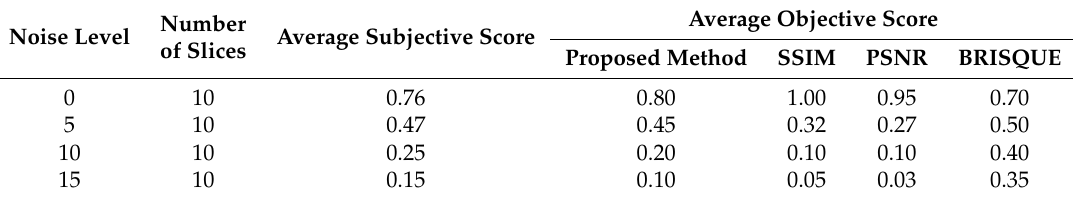
Table 4. Comparative Performance Evaluation of the Proposed Method with SSIM, PSNR and BRISQUE Quality Metrics using Cardiac MRI